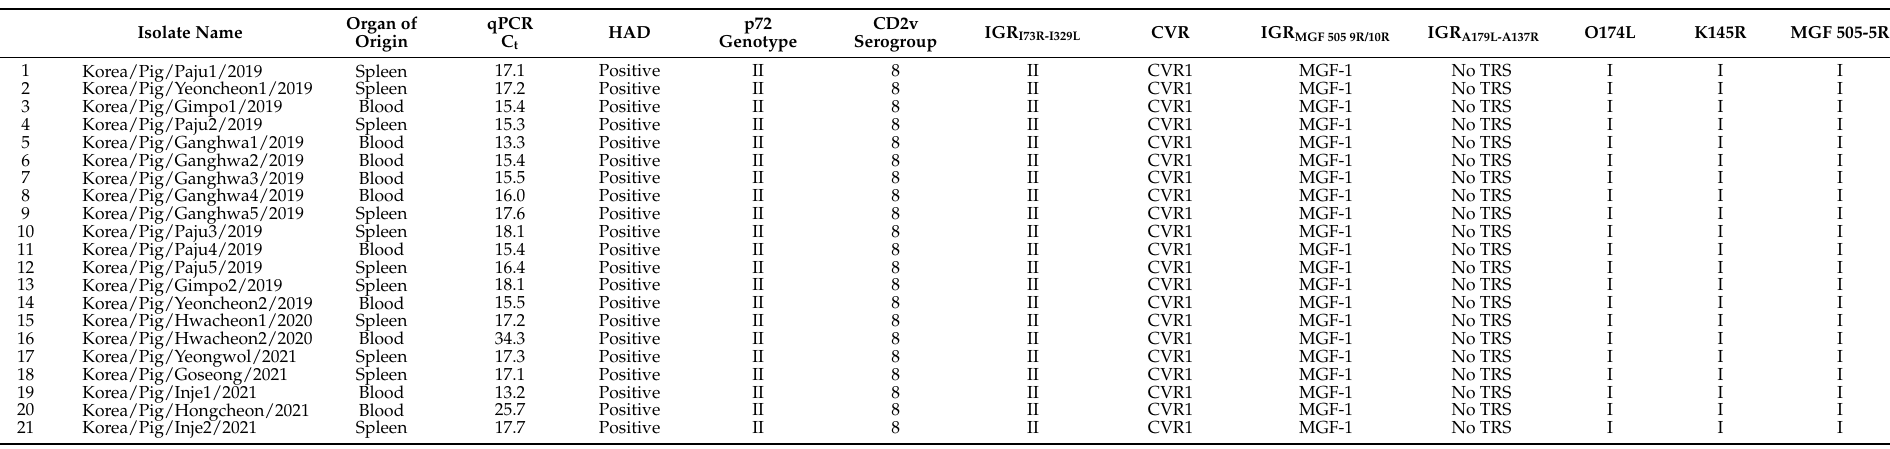
Table 1. Summary of the isolation and genetic characterization results from 21 ASFV isolates from pig farms in South Korea during the 2019–2021